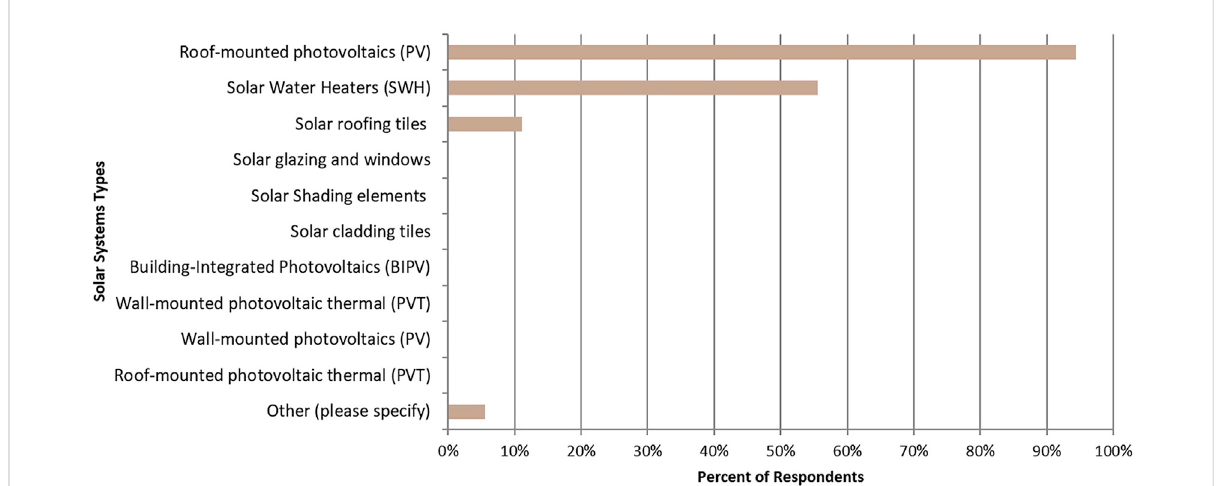
FIGURE 9 Results from the online survey targeting solar systems ’ experts and suppliers. It shows the solar systems that achieve the highest sales in the Egyptian market based on the responses ( n = 20 out of 20 total respondents). Sales was de fi ned as the number of systems sold annually and the respondentscouldselectmultipleoptionsofsystems(X=30totalresponses).BIPV,Building-IntegratedPhotovoltaics;PV,Photovoltaicpanels;PVT, Photovoltaic Thermal systems; SWH, Solar Water